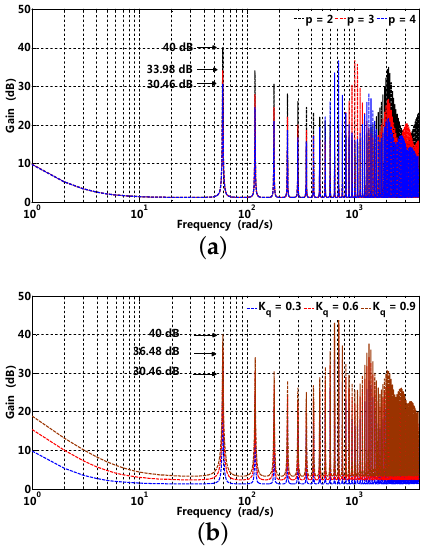
Figure 9. Gain waveforms of q -axis open-loop transfer function with respect to parameter p and K q , where corresponding parameters are N = 1044, ω 0 = 60 rad/s, D = 2.6 and T s = 0.1 ms, respectively. ( a ) parameter p ; ( b ) parameter K q .